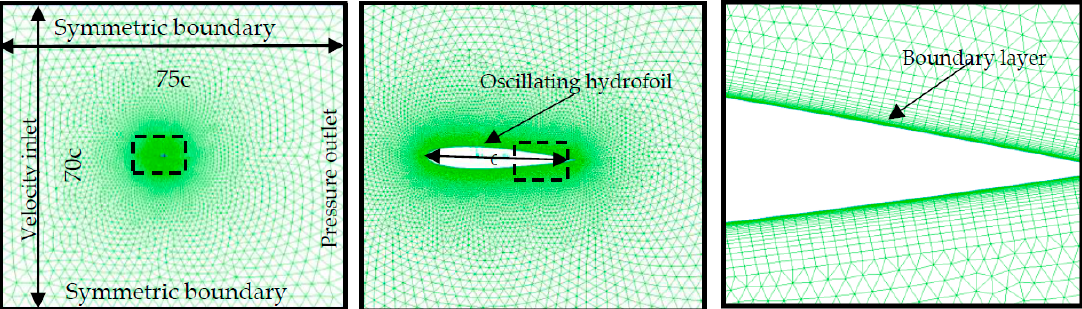
Figure 3. Computational domain and mesh distribution.